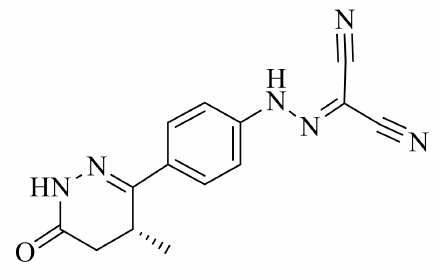
Figure 1. Approved by FDA